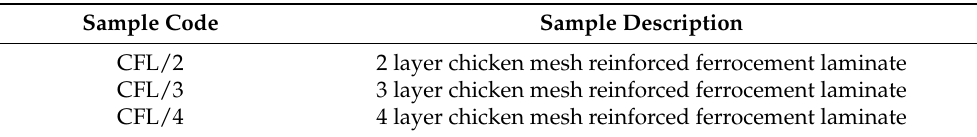
Table 5 Represents the sample code of chicken mesh reinforced ferrocement composites. Table 5. Details of chicken mesh reinforced Ferrocement